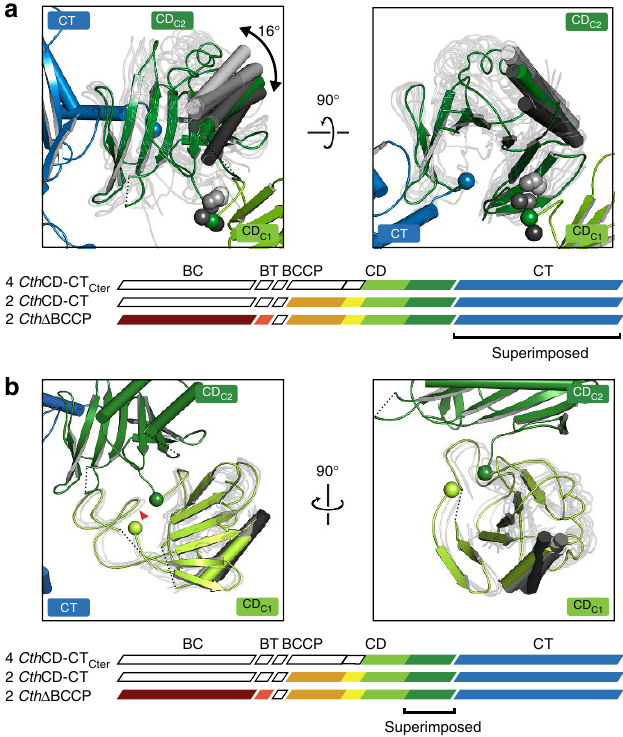
Figure 3 | Variability of the connections of CD C2 to CTand CD C1 in fungal ACC. ( a ) Hinge properties of the CD C2 –CT connection analysed by a CT- based superposition of eight instances of the CD C2 -CTsegment. For clarity, only one protomer of Cth CD-CT Cter1 is shown in full colour as reference. For other instances, CD C2 domains are shown in transparent tube representation with only one helix each highlighted. The range of hinge bending is indicated and the connection points between CD C2 and CT (blue) as well as between CD C1 and CD C2 (green and grey) are marked as spheres. ( b ) The interdomain interface of CD C1 and CD C2 exhibits only limited plasticity. Representation as in a , but the CD C1 and CD C2 are superposed based on CD C2 . One protomer of Cth D BCCP is shown in colour, the CD L domains are omitted for clarity and the position of the phosphorylated serine based on Sce CD is indicated with a red triangle. The connection points from CD C1 to CD C2 and to CD L are represented by green